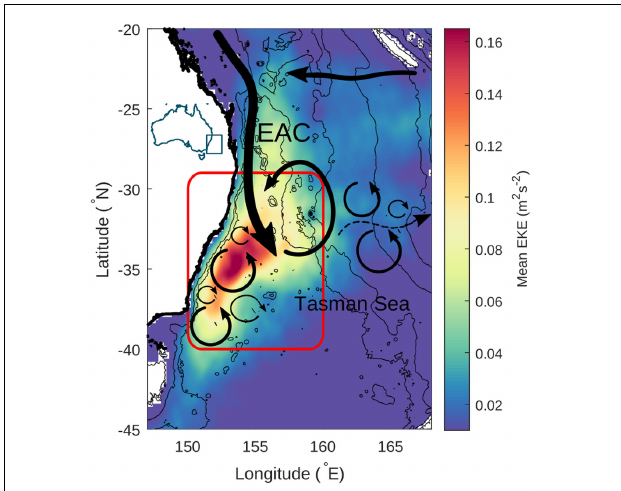
FIGURE 1 | A schematic showing the boundaries of the region analyzed (red box). The mean eddy kinetic energy (EKE, 01/09/1981 to 30/12/2018) is shown with bathymetry contours (0, 200, and 2000 m). Inset shows the map of Australia and the location of the region in context. Arrows indicate the schematic of the mean circulation in the region. EAC stands for the East Australian